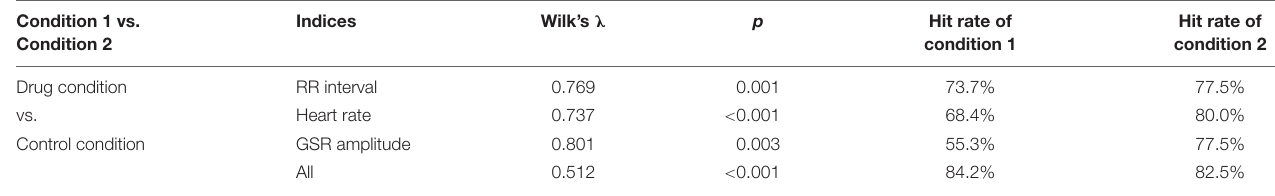
TABLE 1 | Hit rates (i.e., correct classification rates) of guilty and innocent participants, using one of three and all physiological indices in Experiment 1. Condition 1 vs. Condition